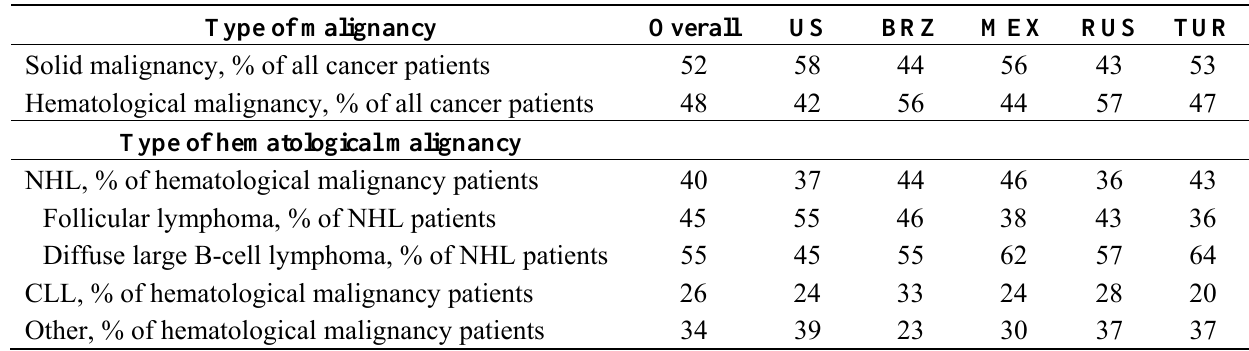
Table 1. Description of the cancer patient population. Type of